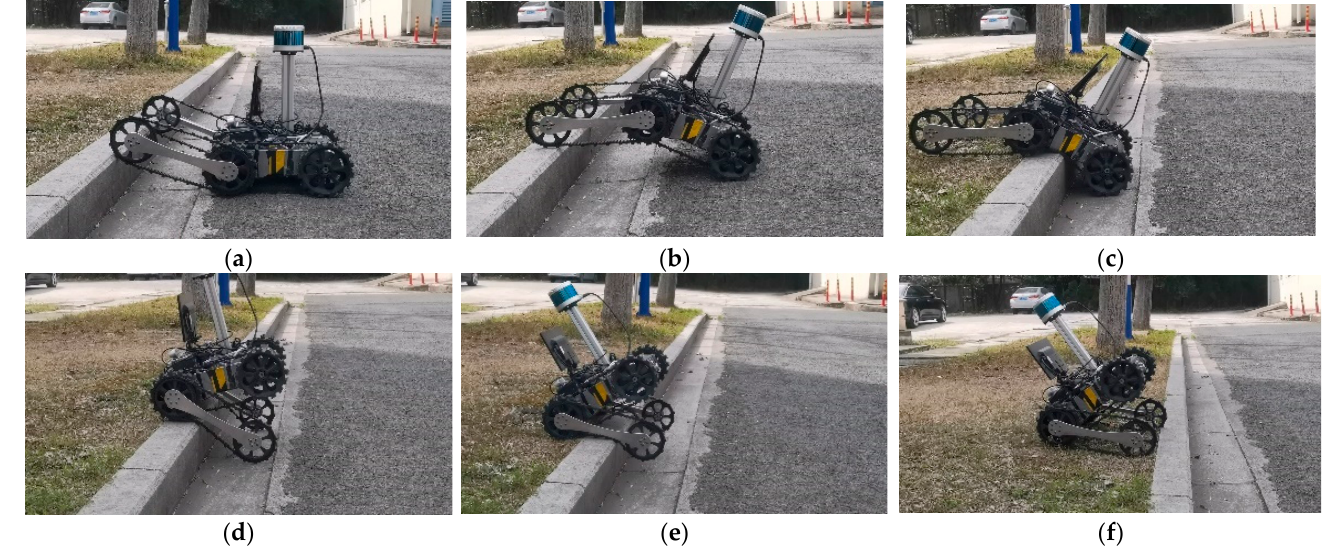
Figure 12. Reverse climbing process of the robot: ( a ) lift the rocker arm; ( b ) track wheels against the step; ( c ) body track against the step; ( d ) radial supporting body; ( e ) centroid crossing the step; ( f ) car body crosses the step.